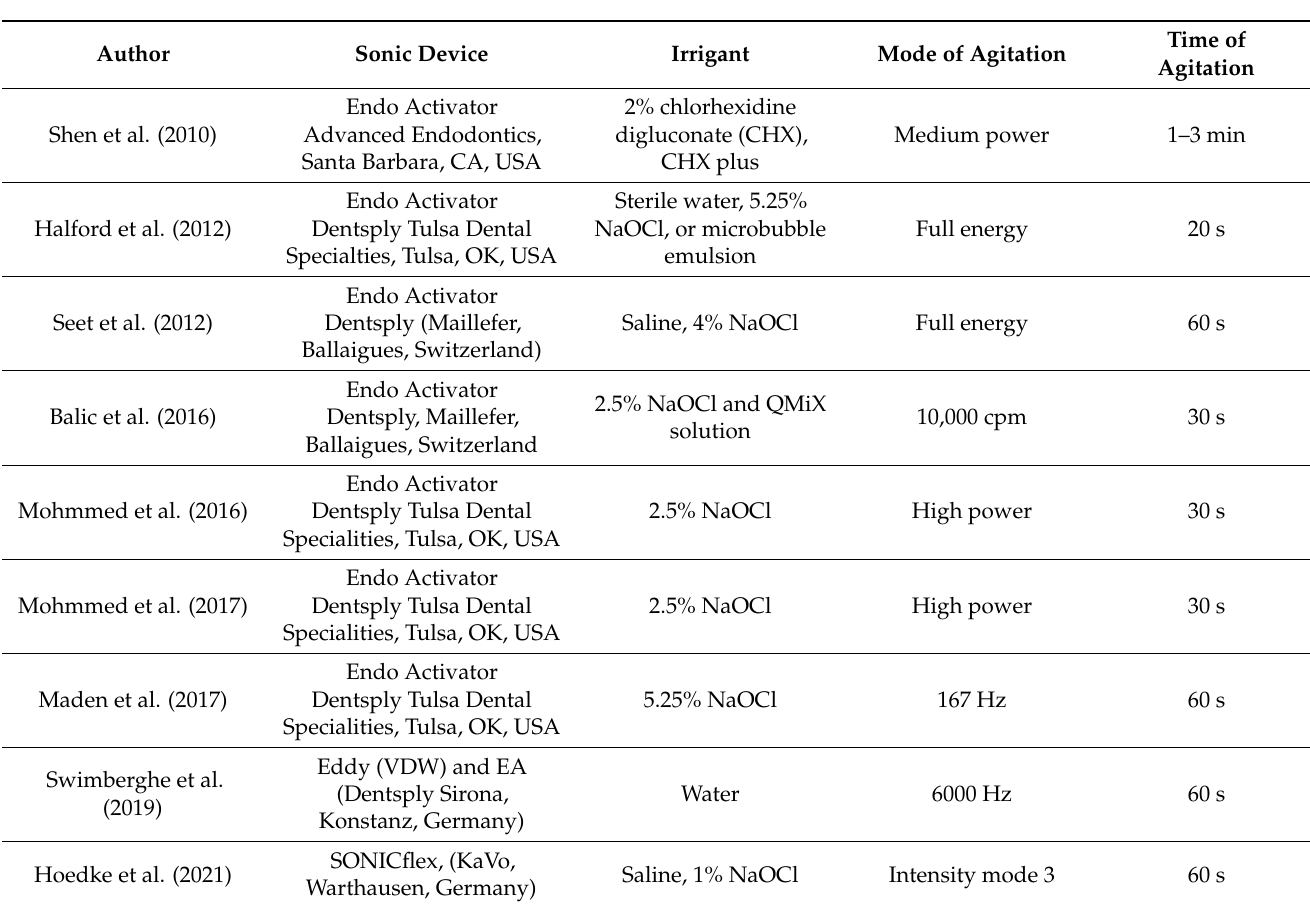
Table 2. Details on irrigants, mode and time of agitation, as well as type of sonic device used for biofilm